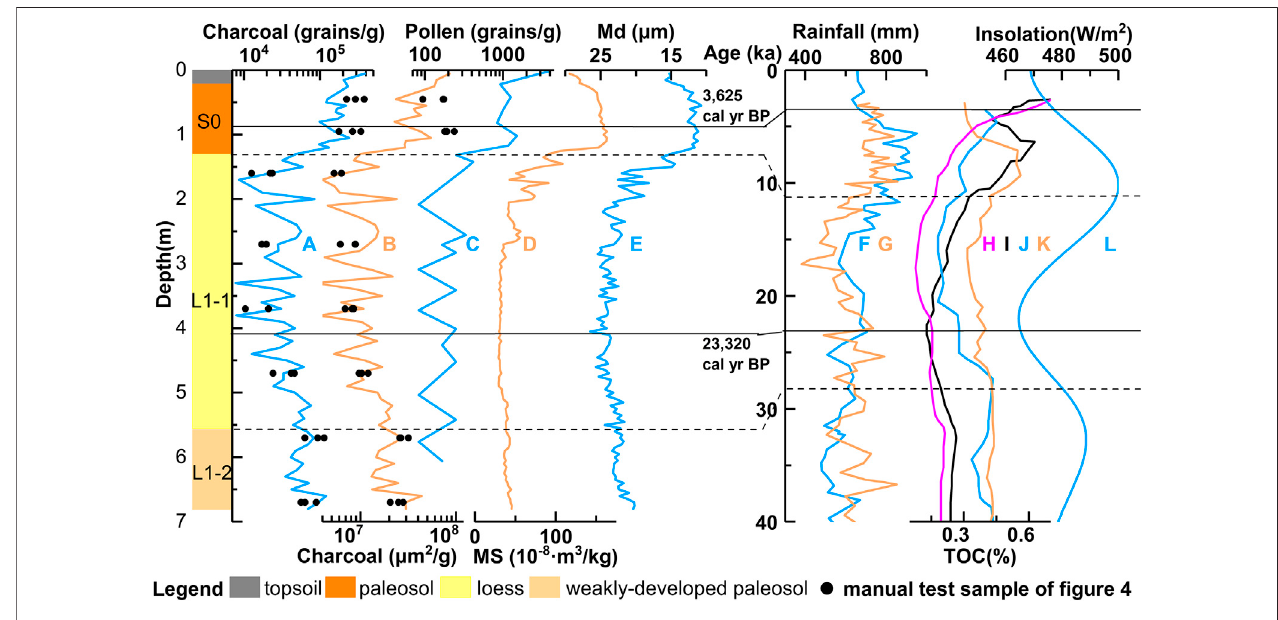
FIGURE 5 | Comparison between the microcharcoal concentration in the Weiyuan section and other environmental indexes nearby. (A) : particle concentration of microcharcoal in Weiyuan (this study); (B) : area concentration of microcharcoal in Weiyuan (this study); (C) : pollen concentration in the Weiyuan section (Yang X et al., 2015); (D) : magnetic susceptibility (MS) in the Weiyuan section (Yang S et al., 2015); (E) : median grain size (Md) in the Weiyuan section (Yang S et al., 2015); (F) : 10 Be based rainfall in the Baoji section (Beck et al., 2018); (G) : phytoliths based mean annual precipitation (MAP) in the Weinan section (Lu et al., 2007); (H – K) : Total organic carbon (Grant et al., 2019) (Grant et al.) content in Luochuan (H) , Xifeng (I) , Weinan (J) , and Lantian (K) respectively (Lu et al., 2019). (L) : summer insolation in 35 ° N(Laskaretal.,2004).Theblackdotsin (A) and (B) aretheresultsanalyzedmanuallyby3peoplein Figure4 asareferencefortheaccuracyoftheautomaticmethod; however, we note that the test sample size in Figure 4 is only 1/9 to the result sample size in (A) and (B) .